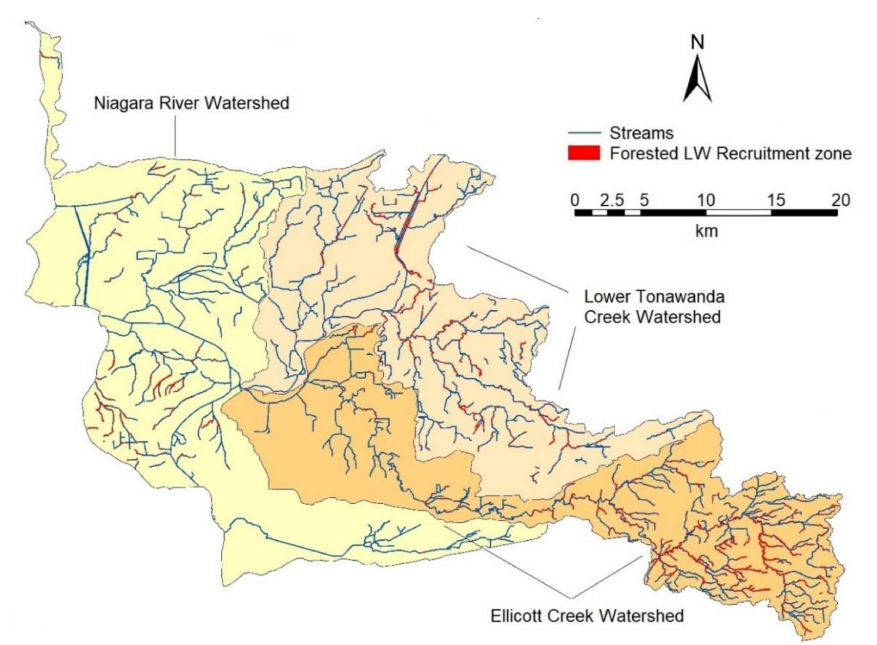
Figure 4. Map illustrating forested large wood (LW) recruitment zones in the Niagara River, Lower Tonawanda Creek, and Ellicott Creek watersheds.